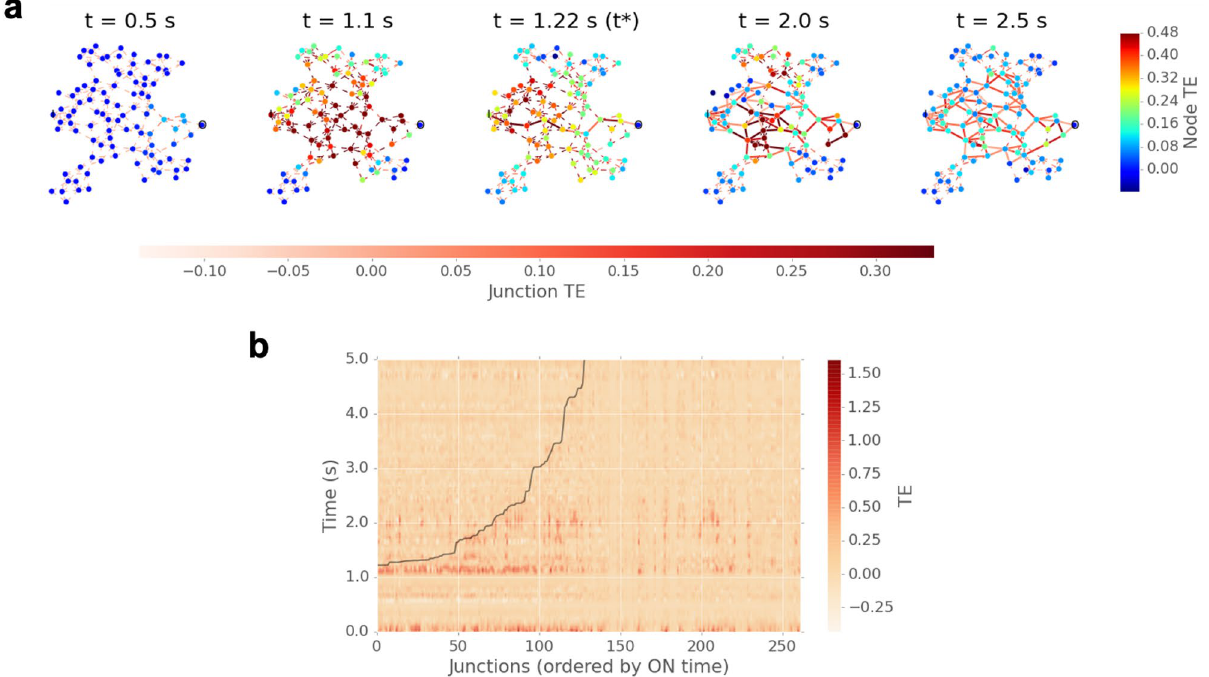
Figure 4. Network information flow dynamics. Top panel—Snapshots of the network taken at time points before activation ( t = 0.5 s), at the onset of activation ( t = 1.1 s), when the first current path forms ( t = 1.22 s), and after network activation ( t = 2.0, 2.5 s). Nodes are colored with time-averaged TE flow (inTE + outTE) within the last 0.2 second window using the Kraskov estimator. Junctions are colored by the sum of corresponding TE in both directions. Bottom panel—heatmap of junction TE as a function of time, with junction number ordered by switch on